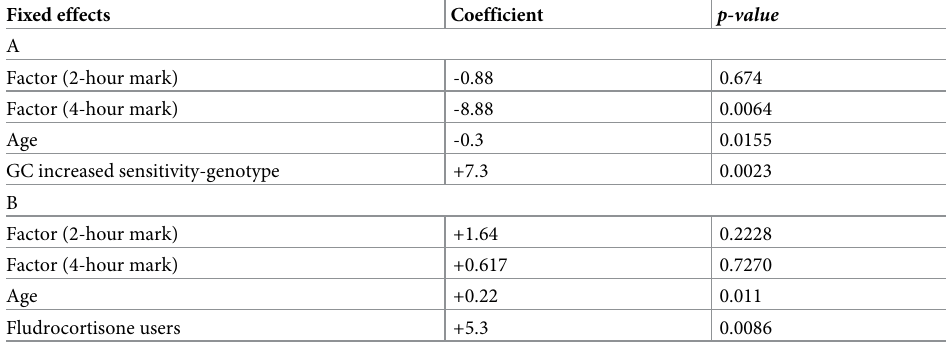
Table 5. Multivariate analysis for average cortisol compared to baseline levels of SV (A) and SW (B) subjects (n =